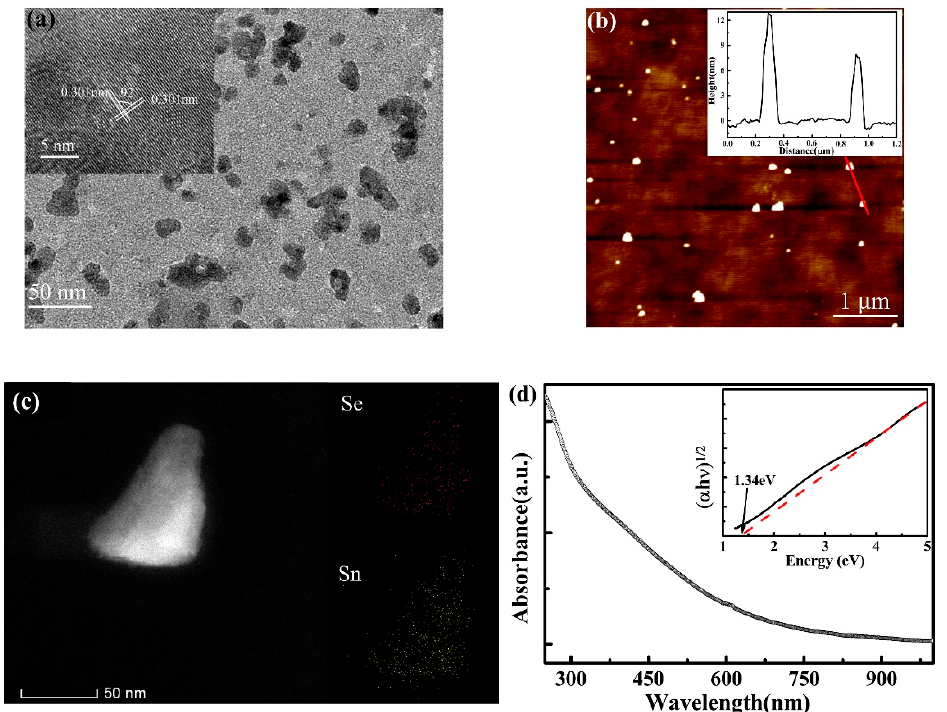
Figure 2. ( a ) TEM image of SnSe NSs, the inset shows HR-TEM image of SnSe NSs ( b ) AFM image of SnSe NSs, inset: the thickness histograms along the red line. ( c ) A single few-layer SnSe NSs and elemental mapping of Sn and Se. ( d ) UV − vis absorption spectrum of the SnSe NSs dispersed in water-ethanol solvent, inset: indirect bandgaps were determined from plots of ( α h ν ) 1/2 versus phonon energy.